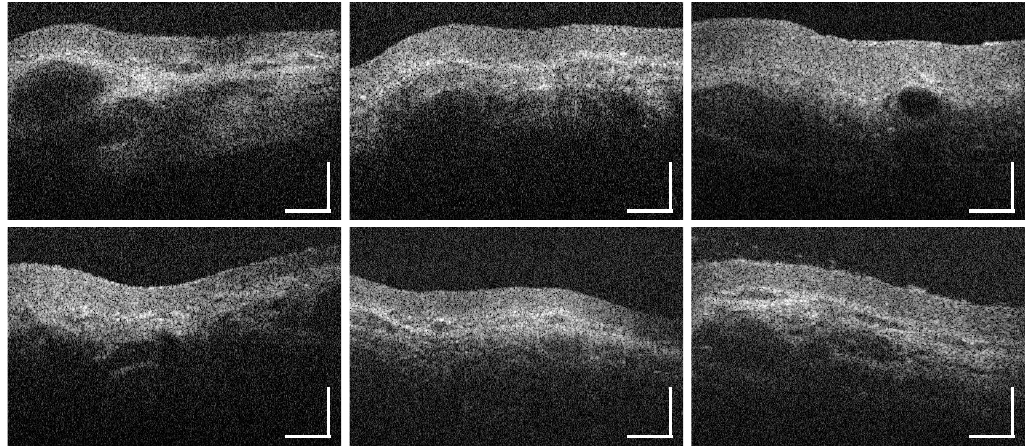
Figure A15. Supplementary intensity-based OCT cross sections of the alveolar mucosa of the lower vestibular region (MP5, Figure 1). Scale bars: 200 µ m.